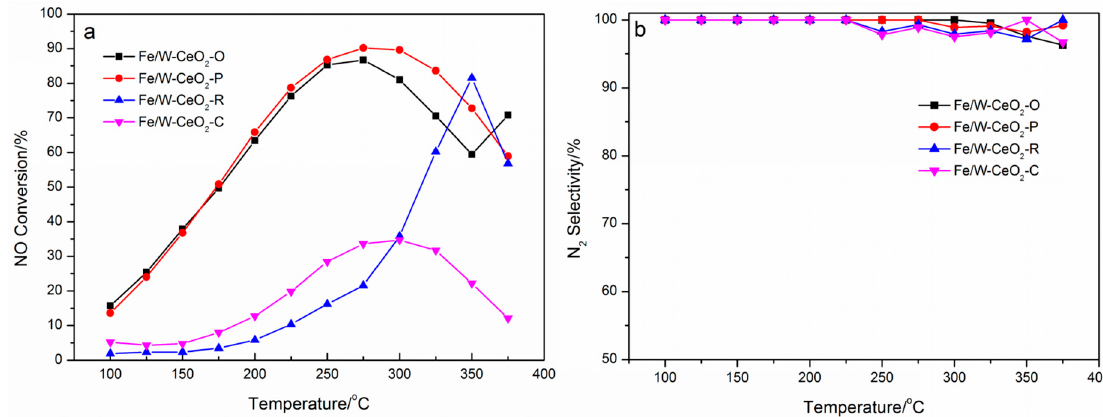
Figure 8. Different morphology Fe/W–CeO 2 catalysts of ( a ) NO conversions and ( b ) N 2 selectivity.